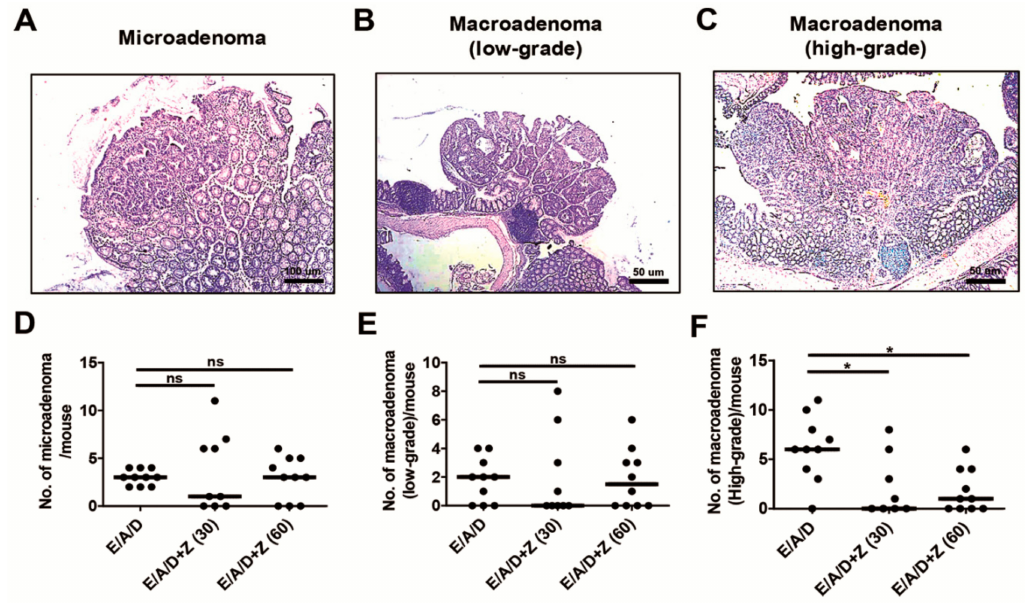
Figure 3. Zerumbone decreases ETBF colonization-promoted high-grade macroadenomas. FFPE colonic tissues of distal colon obtained from AOM-treated BALB / c mice infected with ETBF and subjected to two cycles of DSS (1%) for 9 weeks were excised and stained with H&E. A representative image of microadenoma, low-grade macroadenoma and high-grade macroadenoma is shown. Microadenoma, low-grade macroadenoma and high-grade macroadenoma were counted for two H&E-stained distal colon of sections per mouse. ( A ) Histology of microadenoma, × 100 magnification. ( B ) Histology of low-grade macroadenoma, 50 × magnification. ( C ) Histology of high-grade macroadenoma, 50 × magnification. ( D ) Number of microadenoma per mouse. ( E ) Number of low-grade macroadenoma per mouse. ( F ) Number of high-grade macroadenoma per mouse. E, ETBF; A, AOM; D, DSS; Z (30), Zerumbone (30 mg / kg) and Z (60), Zerumbone (60 mg / kg). Each dot represents one mouse. Scatter plot. Horizontal bar, median. * p < 0.05. ns, no statistical